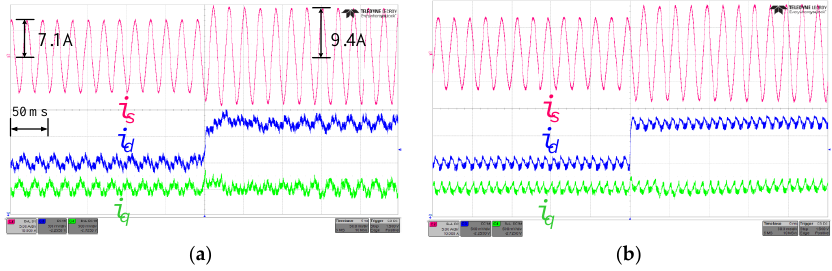
Figure 12. Experimental results for the inductance current i s , the d-axis current i d , the q-axis current i q when 𝐿̂ = L . ( a ) ICSF-based PI control; and ( b ) the proposed complex vector based control.